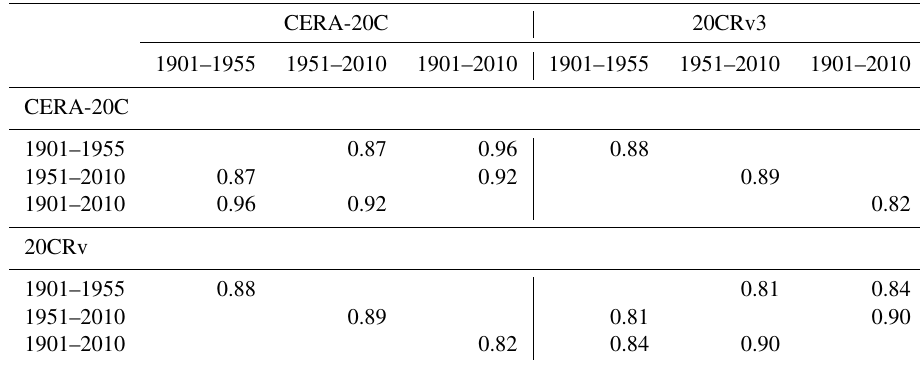
Table 3. Multivariate network quality scores between reanalyses in various time